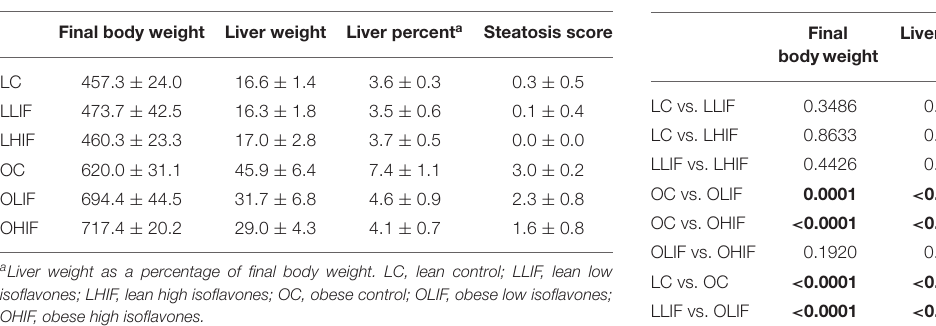
TABLE 3 | Significance level ( p -value) of pairwise contrasts between lean and obese rats on low and high diet isoflavones for final body weight, liver weight, liver weight as percent of body weight and steatosis